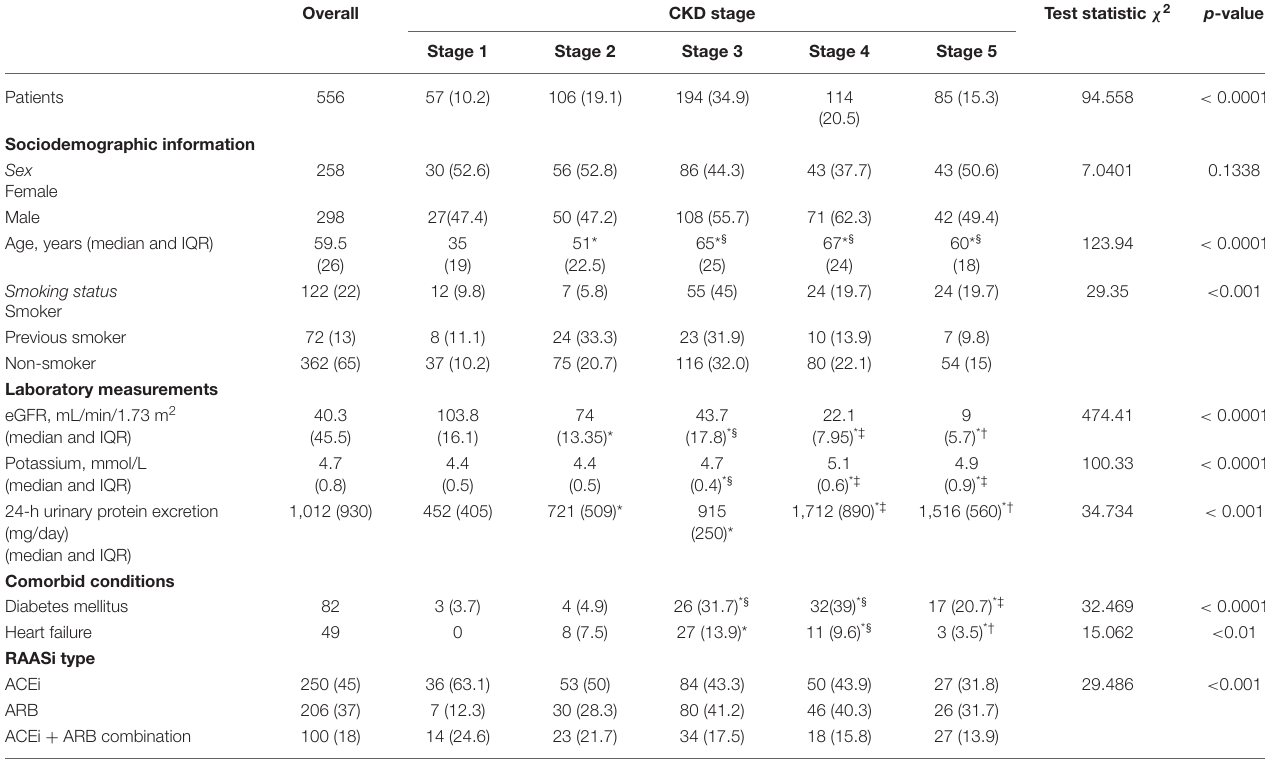
TABLE 1 | Baseline characteristics of the study cohort, overall and by CKD stage.